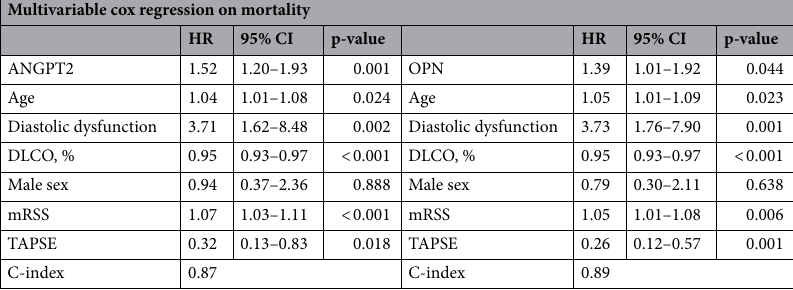
Table 3. Prediction of mortality by angiopoietin 2 and OPN in multivariable cox regression. ANGPT2 angiopoietin 2, CI confidence interval, DLCO diffusion capacity of the lungs for carbon monoxide, HR hazard ratio, mRSS modified Rodnan skin score, OPN osteopontin, TAPSE tricuspid annular plane systolic excursion. HR of ANGPT2 and OPN represent an increase of one standard